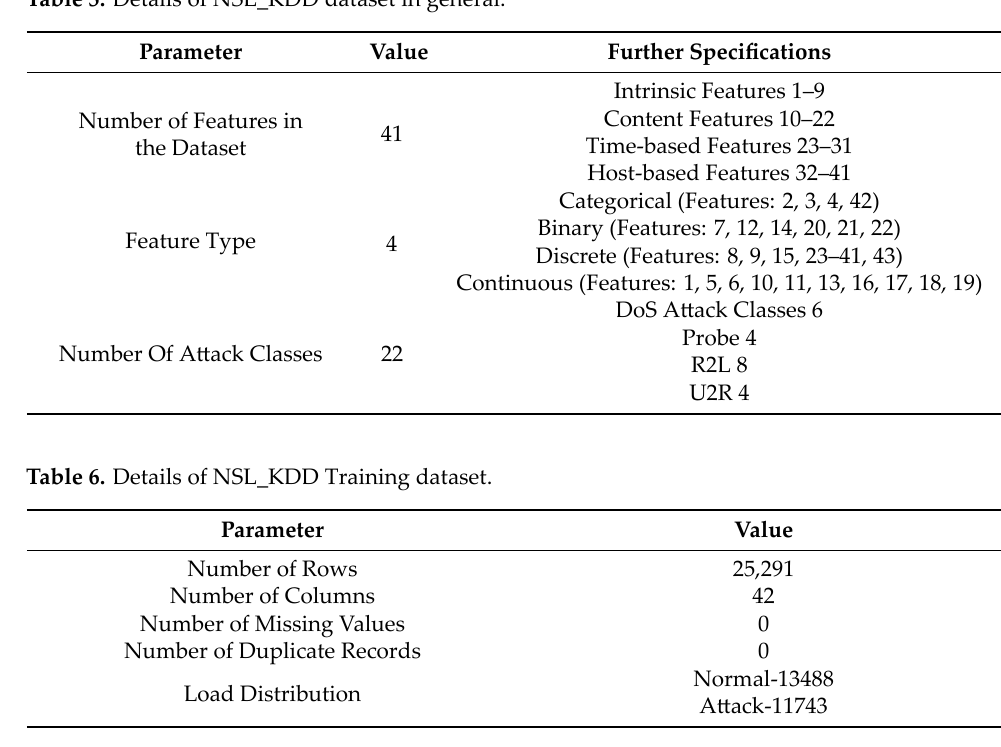
Table 5. Details of NSL_KDD dataset in general.